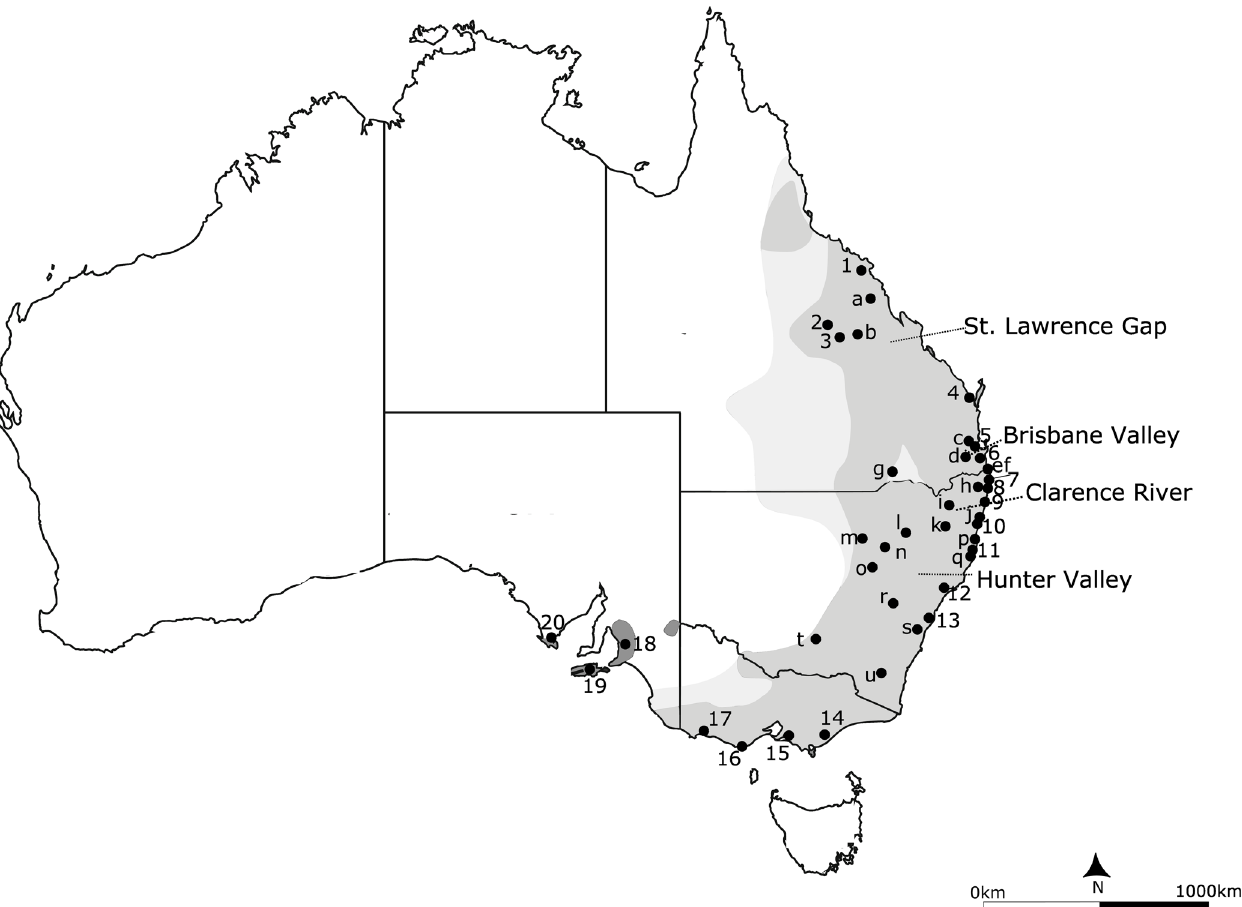
Fig 1. Geographical distribution of the koala, Phascolarctos cinereus , showing the sampling locations. The current distribution is shown in grey, with the historical range in light grey and introduced populations in dark grey. Sampling locations are 1, Whitsunday/Mackay; 2, Blair Athol; 3, Clermont; 4, Maryborough; 5, Redlands; 6, Coomera; 7, Tyagarah; 8, Ballina; 9, Iluka; 10, Pine Creek; 11, Port Macquarie; 12, Maitland; 13, Campbelltown; 14, Strzelecki/East Gippsland; 15, French Island; 16, Cape Otway; 17, Bessiebelle; 18, Mt. Lofty Ranges; 19, Eyre Peninsula; 20, Kangaroo Island; a, Isaac Region; b, Peak Downs; c, Brookfield; d, Peak Crossing; e, Tweed Heads; f, Tanglewood; g, Balonne/Goondiwindi; h, Lismore; i, Glen Innes; j, Grafton; k, Armidale; l, Gunnedah; m, Coonamble; n, Coonabarabran; o Dubbo; p, Kempsey; q, Dunbogan; r, Bathurst; s, Mittagong; t, Narrandera; u, Bredbo. Sampling locations 1 – 20 contain at least 7 individuals, while sites a-u contain fewer individuals and/or individuals were widely dispersed over a large area. Putative biogeographic barriers Brisbane Valley and Clarence River, St. Lawrence Gap and Hunter Valley are shown as dashed